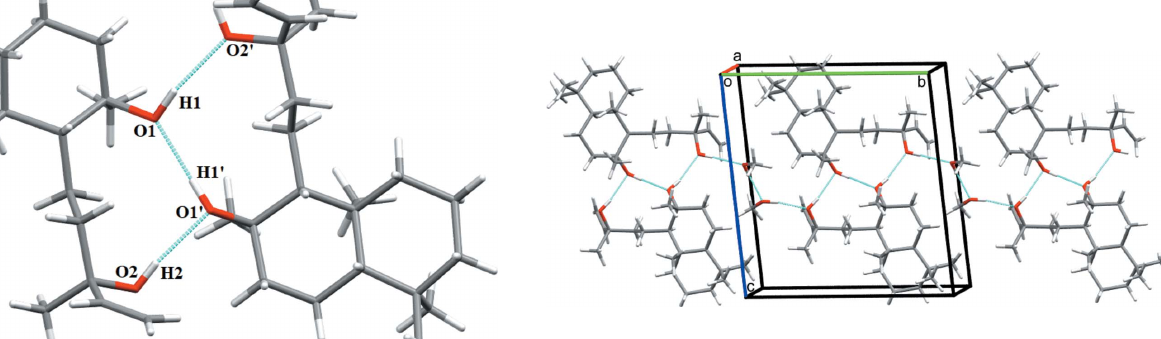
Figure 3 Packing diagram of 1 showing the formation of a [010] chain of molecules linked by O—H (cid:2)(cid:2)(cid:2) O hydrogen bonds (dotted lines).